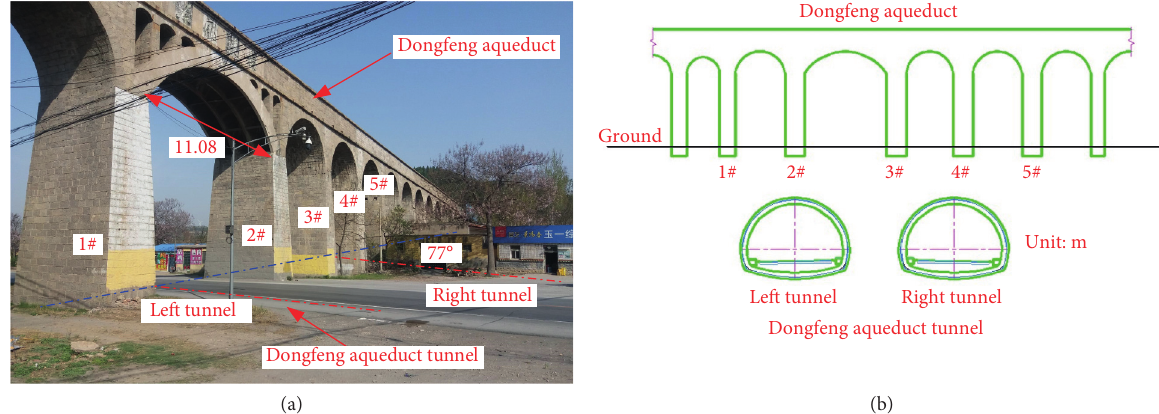
Figure 1: Location map of Dongfeng Aqueduct tunnel: (a) spatial position; (b)